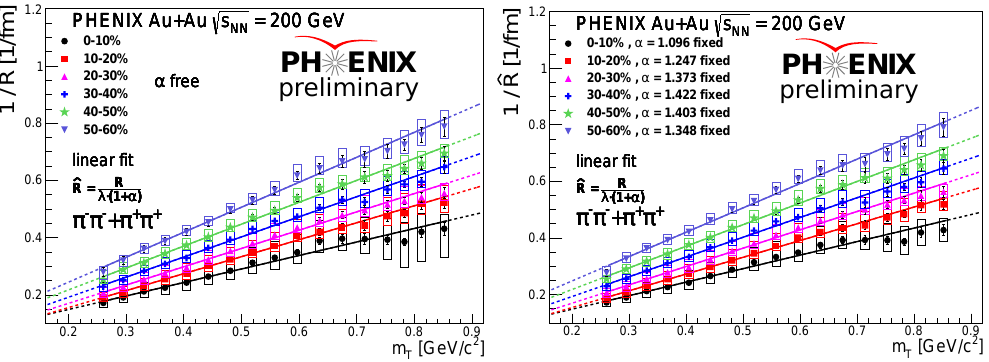
Figure 7. The new, empirically found scaling variable does not depend on the α fixation. The statistical errors are shown with errorbars and the systematical uncertainties